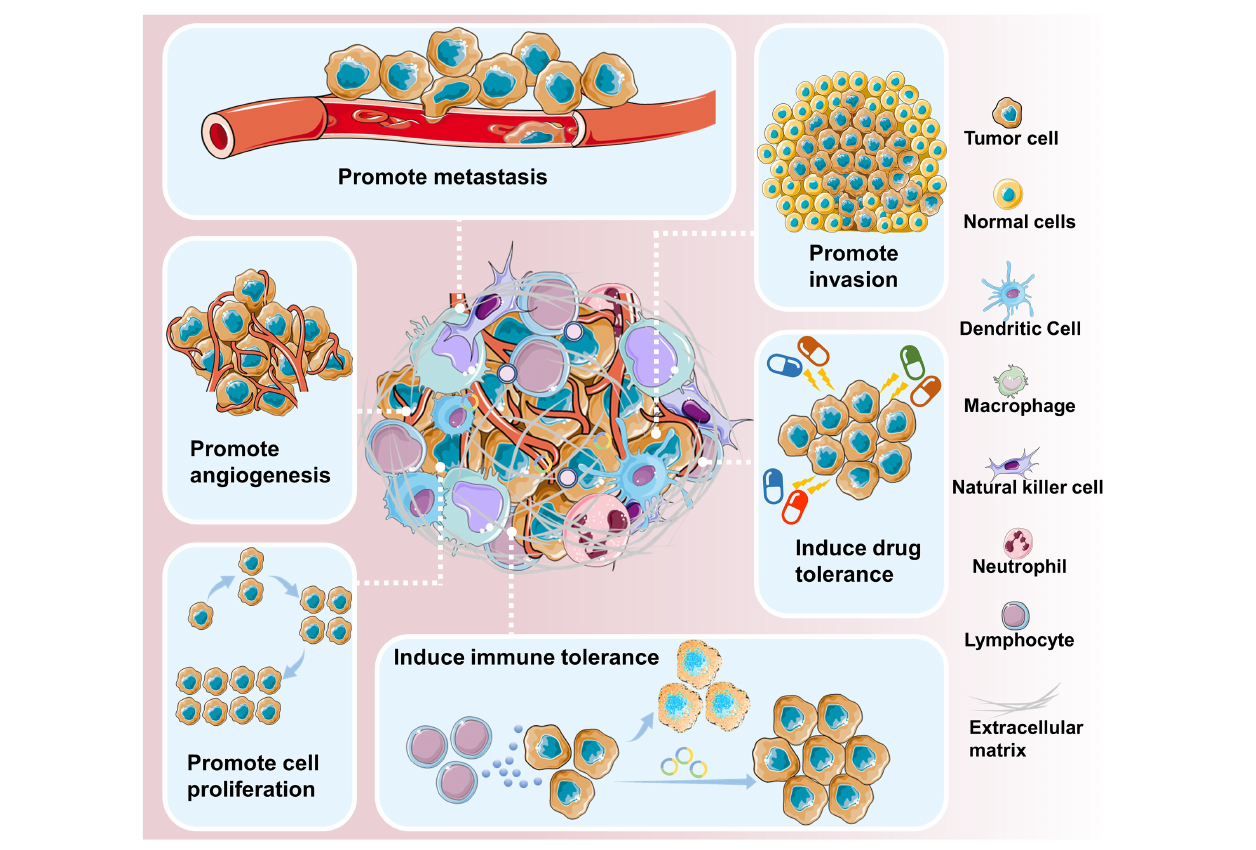
FIGURE 2 | circRNAs are involved in cancer development and progression. circRNAs have been shown to contribute to various aspects of cancer progression, including promoting metastasis, promoting invasion, inducing drug tolerance, inducing immune tolerance, promoting cell proliferation, and promoting angiogenesis.